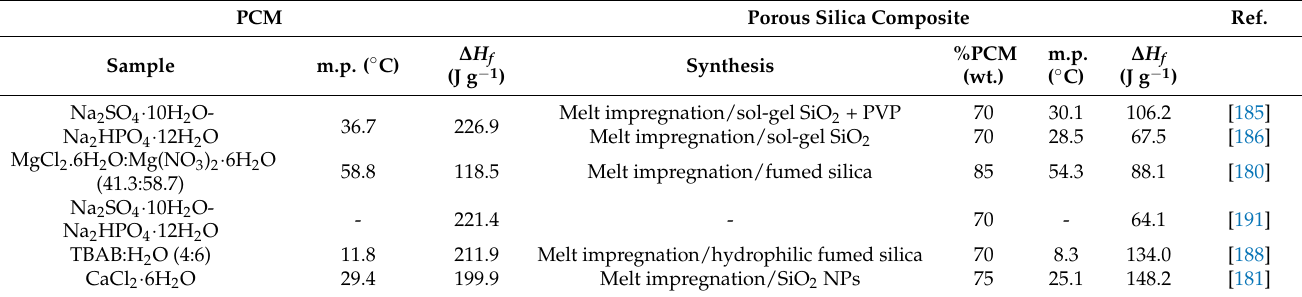
Table 6. Representative examples of hydrated salts as phase change materials in porous silica composite PCMs. PCM Porous Silica Composite Ref.